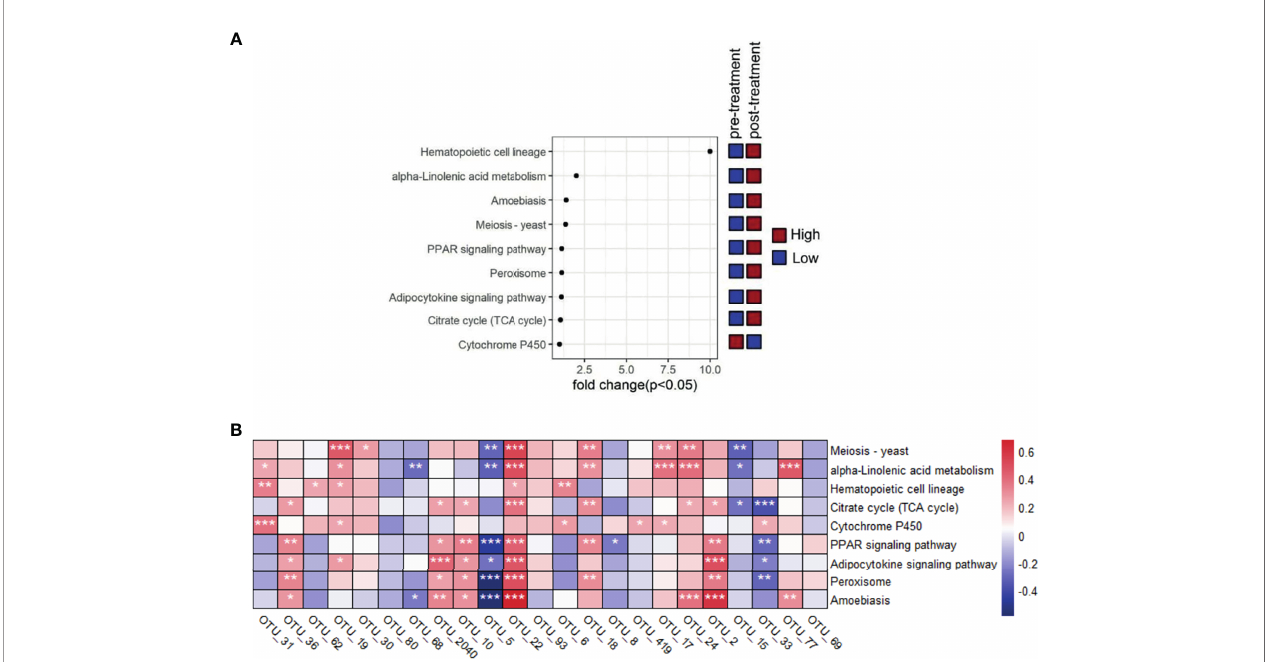
FIGURE 4 | Comparison of metabolic pathway at different time points and the association between featured bacterial taxa and the distinguished pathways that were screened based on Kruskal-Wallis test ( p <0.05). (A) Comparison of these distinguished pathways between pretreatment and post-treatment groups. (B) The correlationship between the nine distinguished pathways and the 23 signi fi cantly differed genera screened by Kruskal-Wallis test ( p